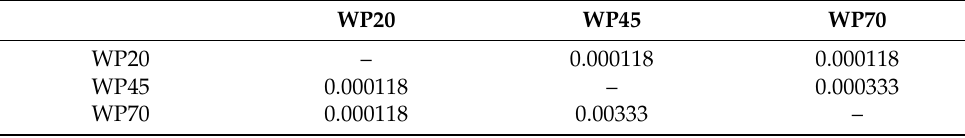
Table 6. Results of Tukey’s post hoc test for the WP group of dies.